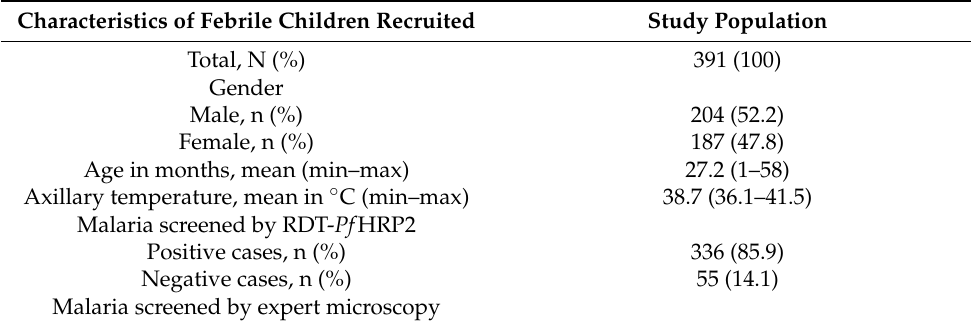
Table 1. Baseline characteristics of study